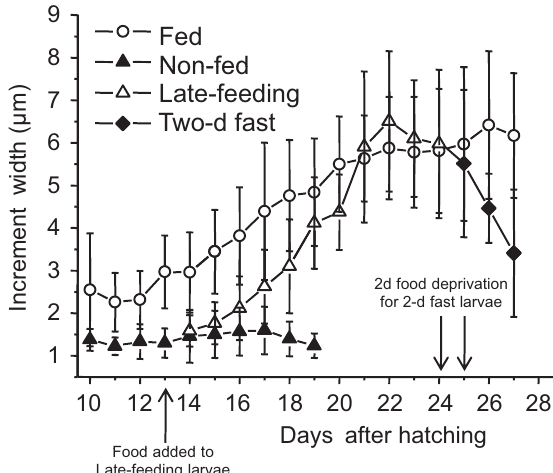
Fig . 4. – Absolute increment widths on the sagittae under all four feeding